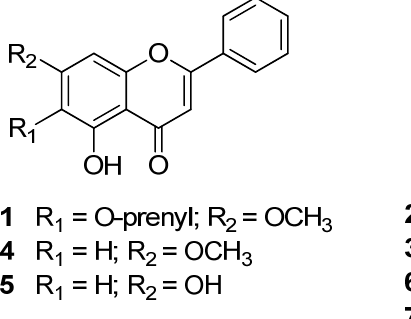
Figure 1. Chemical structures of 1 – 7 .